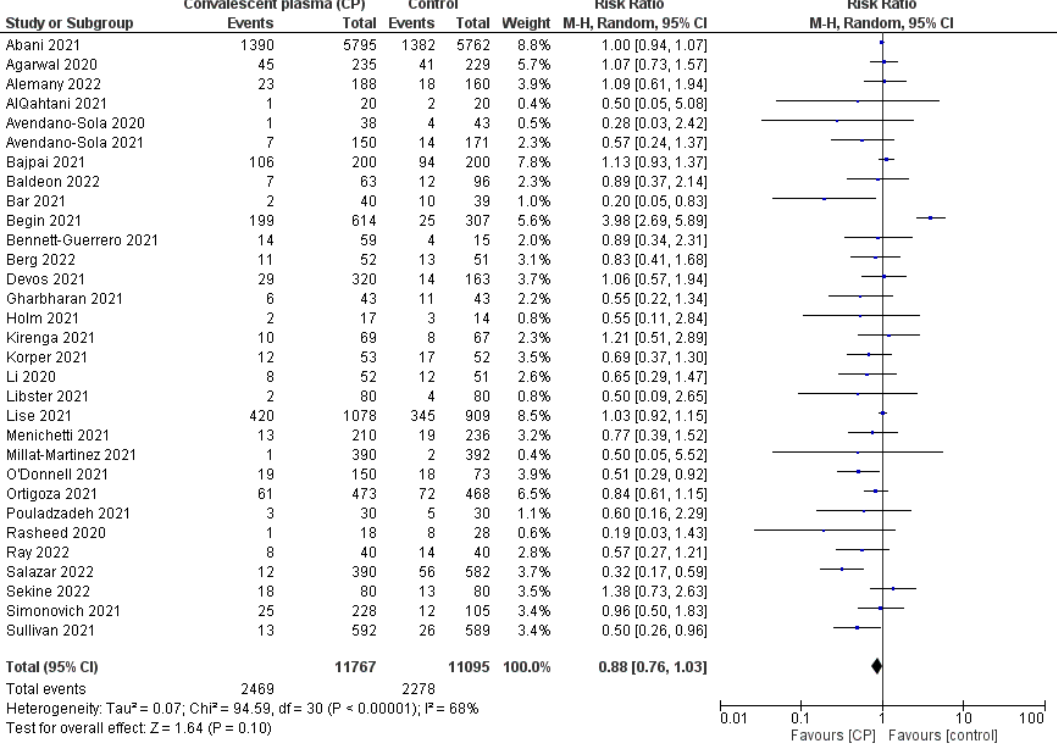
Figure 2. Comparison of reduction in all-cause mortality (number of events) between CP and SOC or placebo groups [8,14,16–22,24–29,31–46]; ( ) RR of individual studies; ( ) RR summary of the comparison.